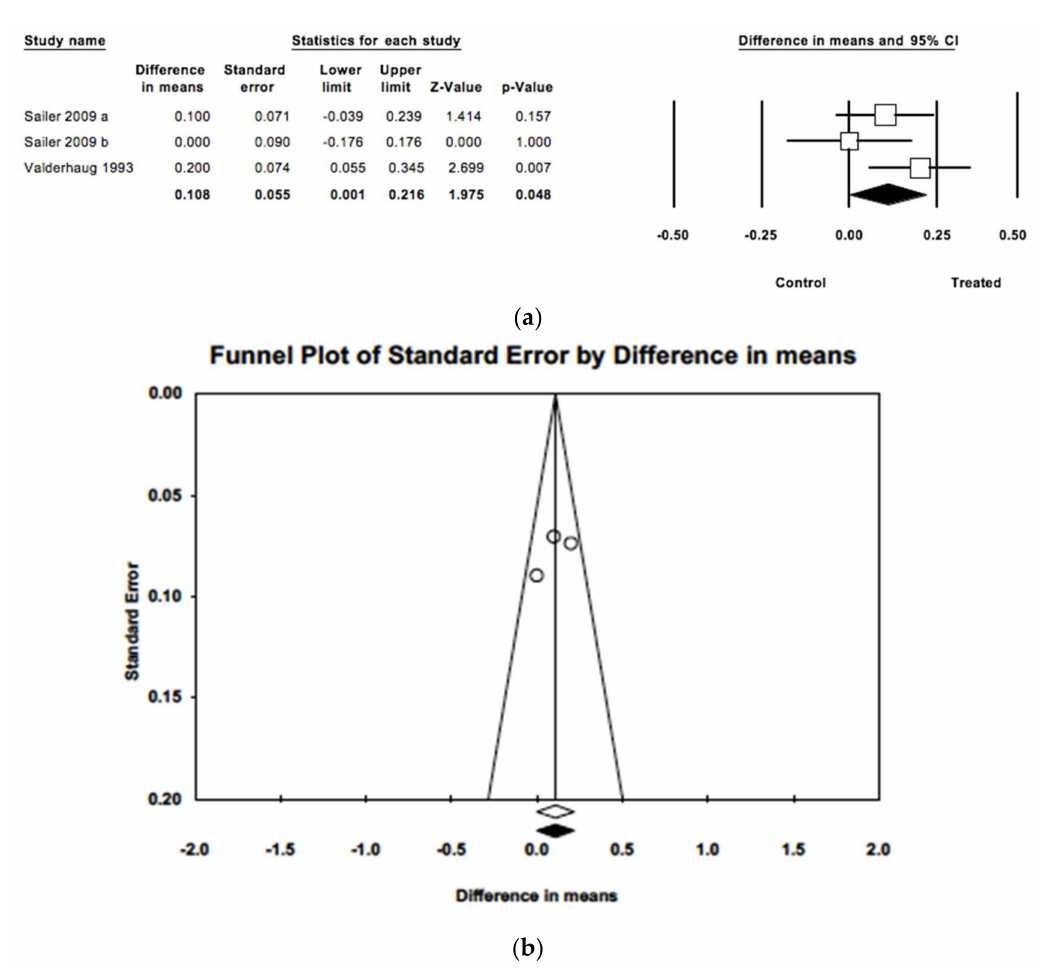
Figure 7. ( a ) Forest plot of meta-analysis of mean probing depths comparing treated and untreated groups. ( b ) Funnel plot with imputed and observed